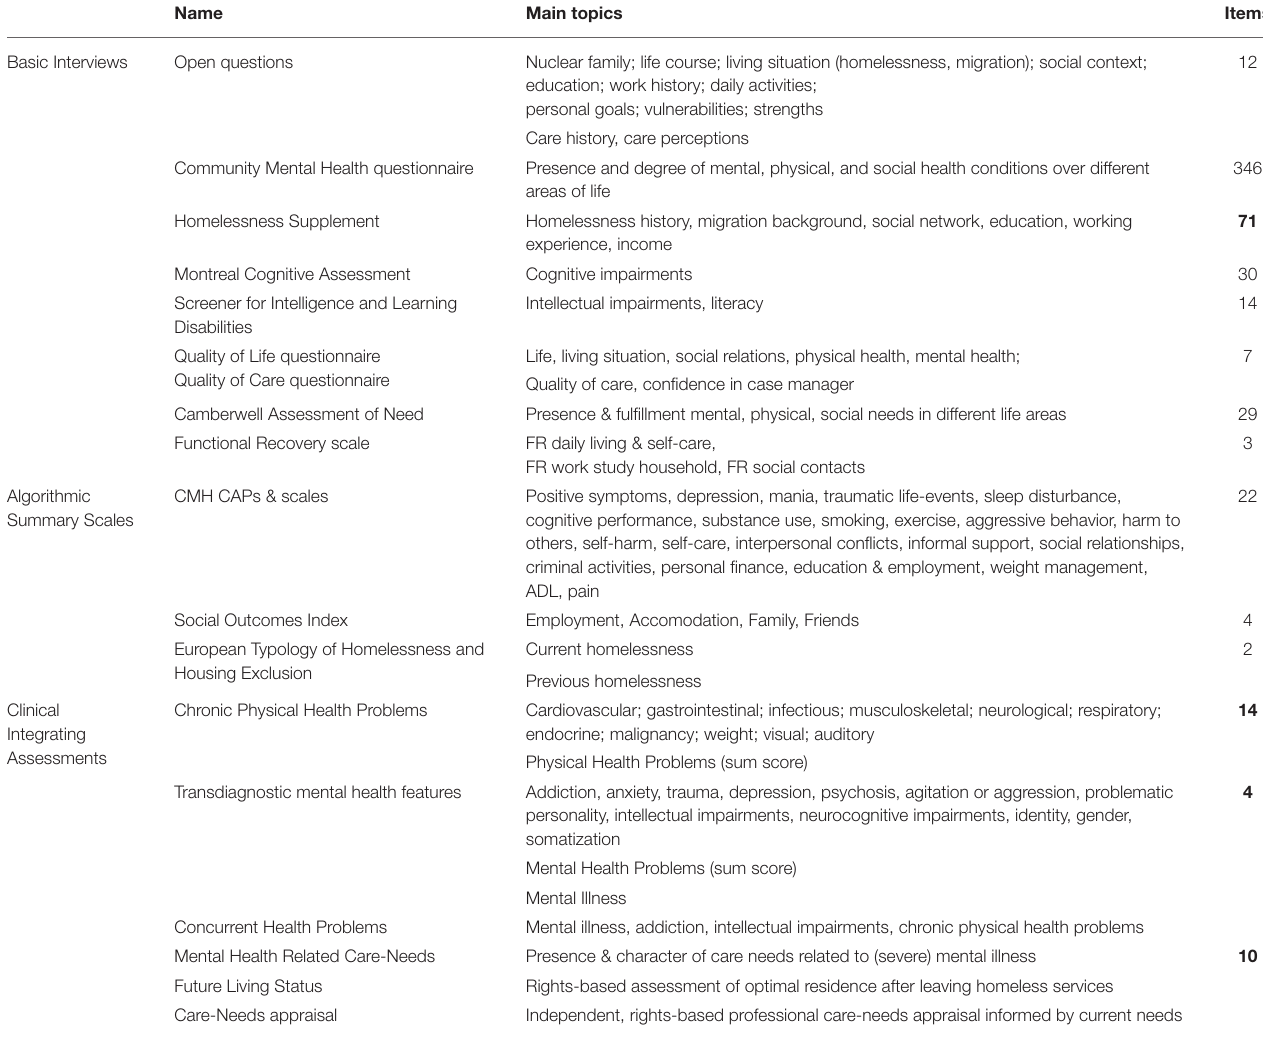
TABLE 1 | HOP-TR assessment approach.